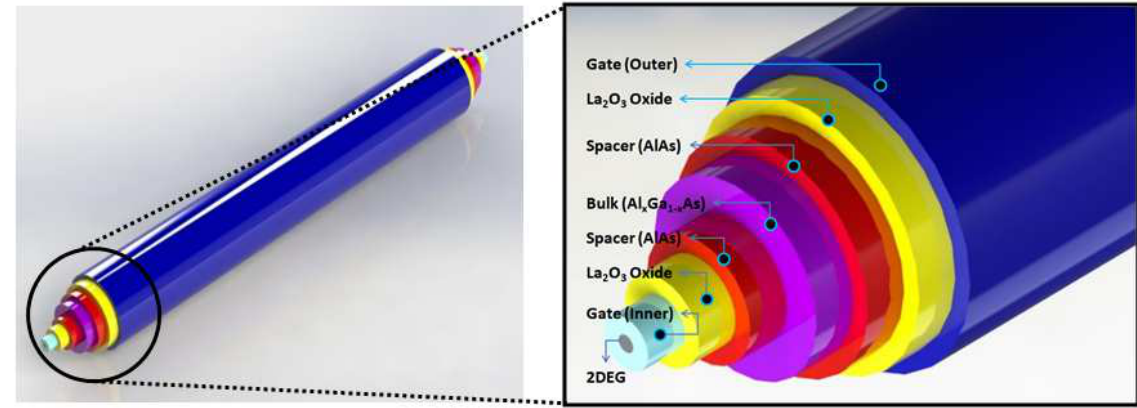
Figure 1. The CSDG MOSFET device showing the cylindrical layer structure [6].